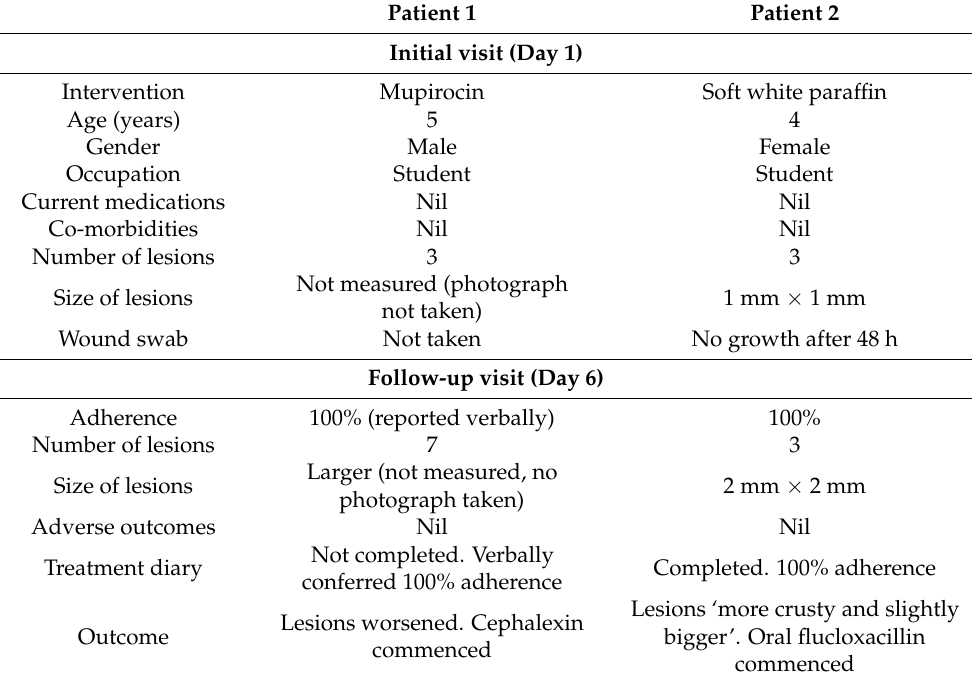
Table 1. Patient demographics and clinical data at initial and follow-up visits.